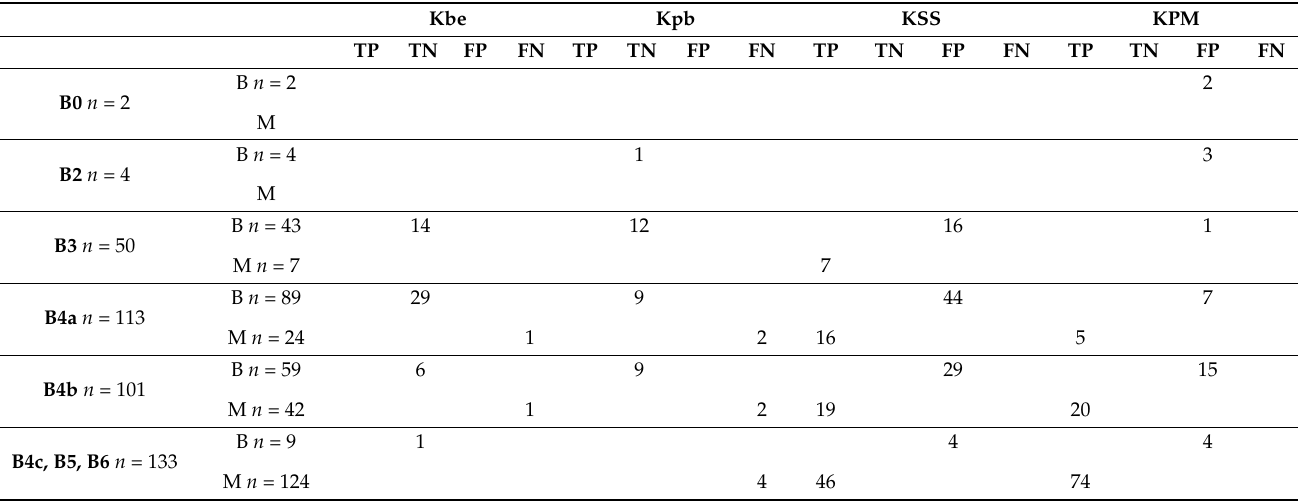
Table 3. Correlation of BI-RADS and KOIOS results against pathology diagnosis.